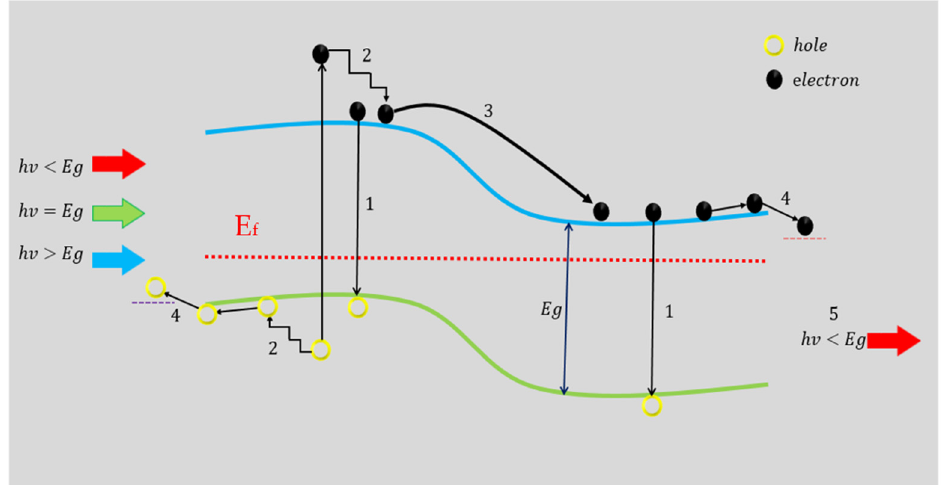
Figure 1. An energy band diagram showing the major energy lack pathways: (1) recombination loss; (2, 3, and 4) thermalization loss; (5) photons with insufficient energy cause non-absorption. Therefore, three solutions were proposed to solve those problems [18]: (a) increasing the number of bandgaps, (b) extraction of the carriers before thermalization and (c) MEG per high energy photon [23].